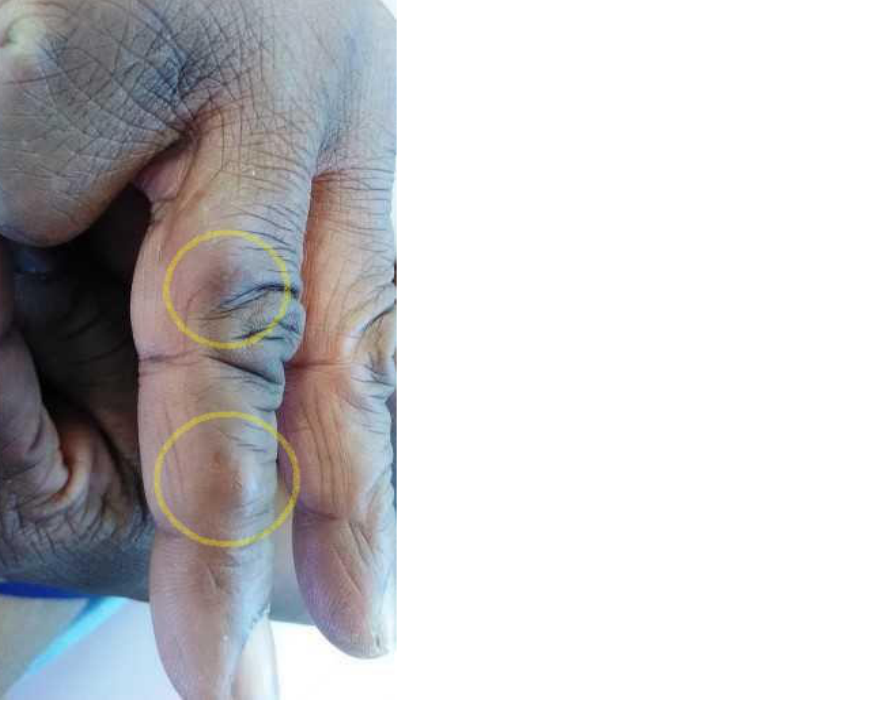
Figure 3. Two subcutaneous nodules on the first and second phalanges of the fourth right finger (yellow circles).